Question: Name the type of graph shown.
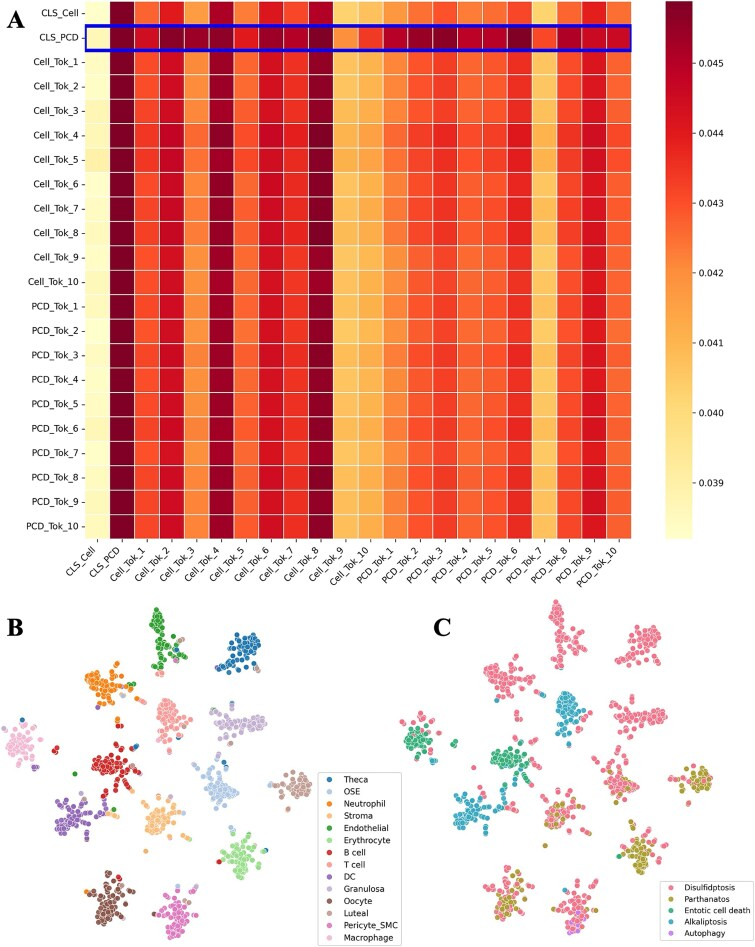
Answer: heatmap